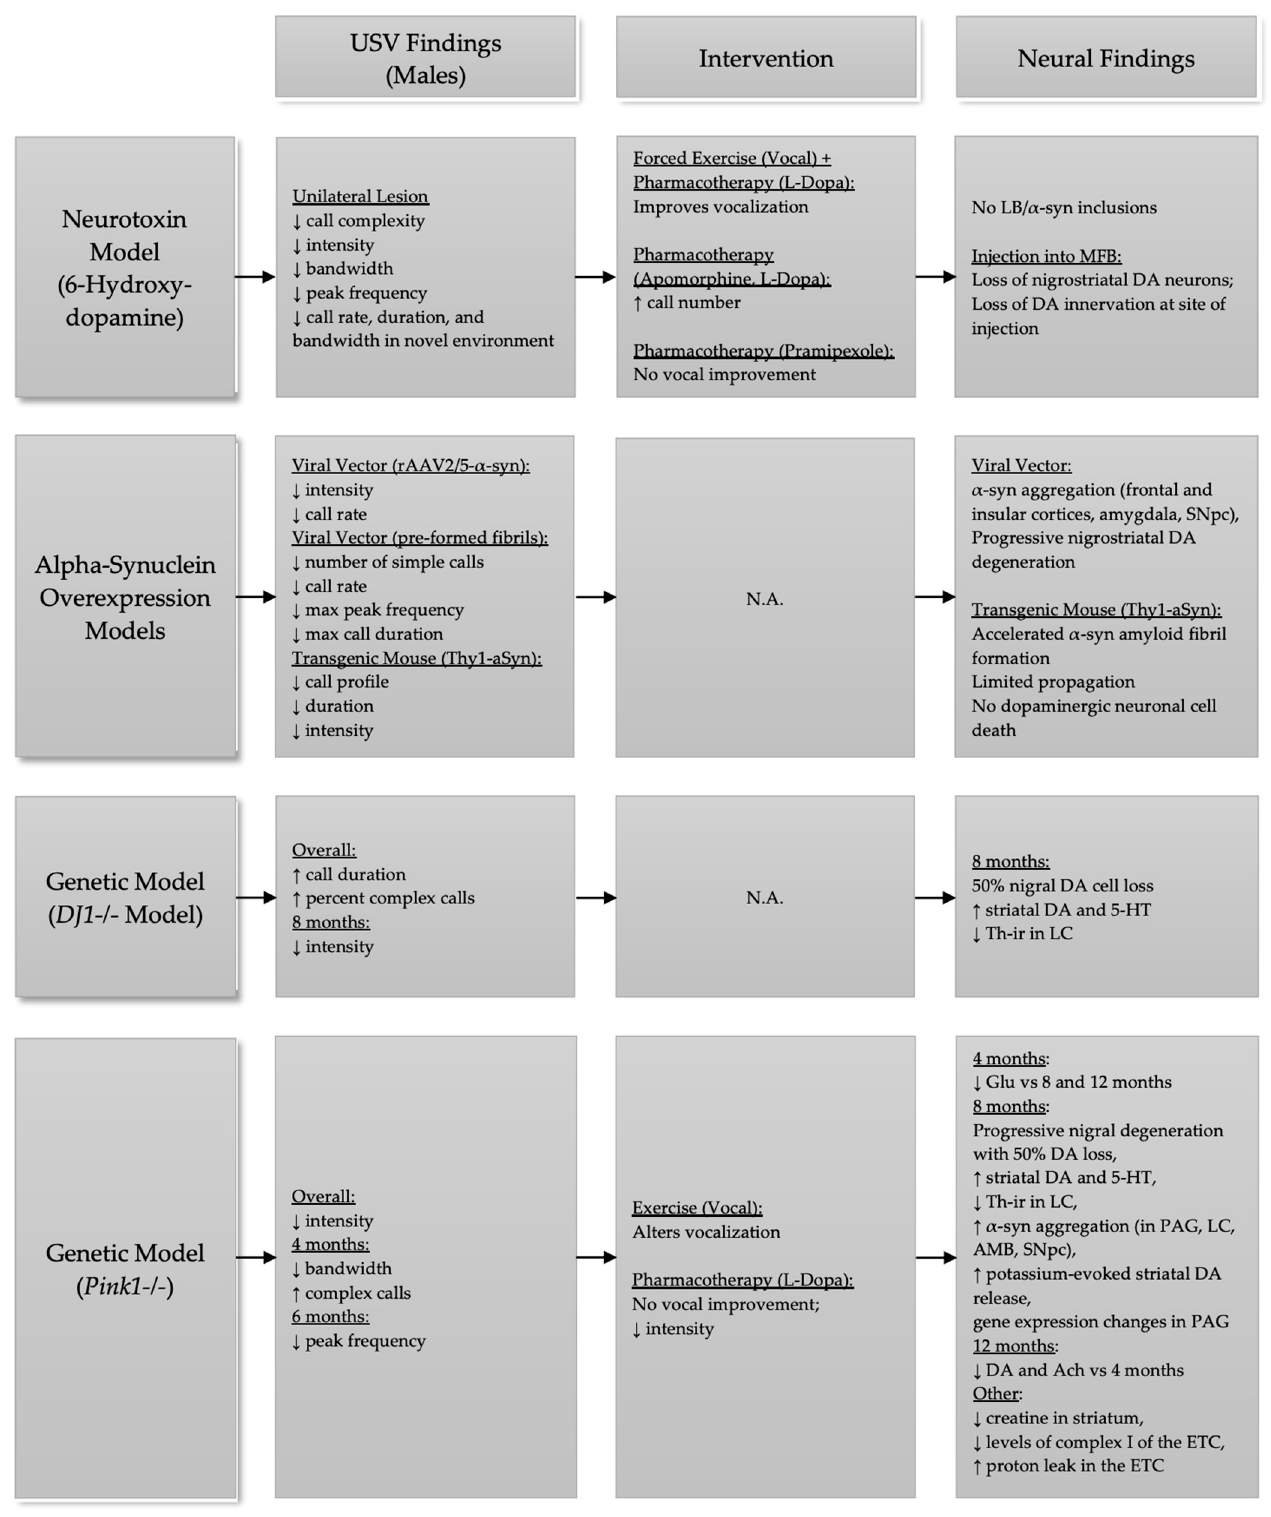
Figure 2. Summary of model-specific USV, intervention, and neural findings in male rats. Ach = acetylcholine, AMB = nucleus ambiguus, α -syn = alpha-synuclein, DA = dopamine, ETC = electron transport chain, Glu = glutamate, LB = Lewy bodies, LC = locus coeruleus, L-Dopa = levodopa, MFB = medial forebrain bundle, PAG = periaqueductal gray, SNpc = substantia nigra pars compacta, Th-ir = tyrosine hydroxylase immunoreactivity, 5-HT = serotonin, ↓ = decrease, ↑ = increase. Underlined text notes category.